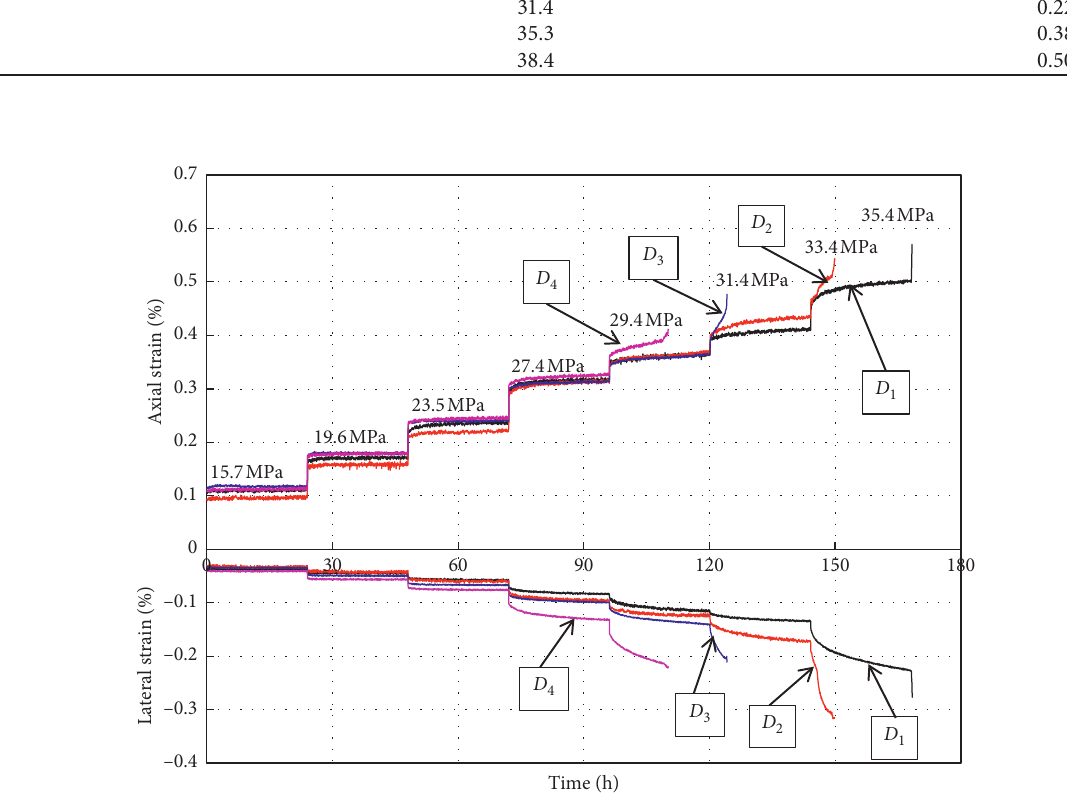
Figure 4: Creep test results of rock with different initial